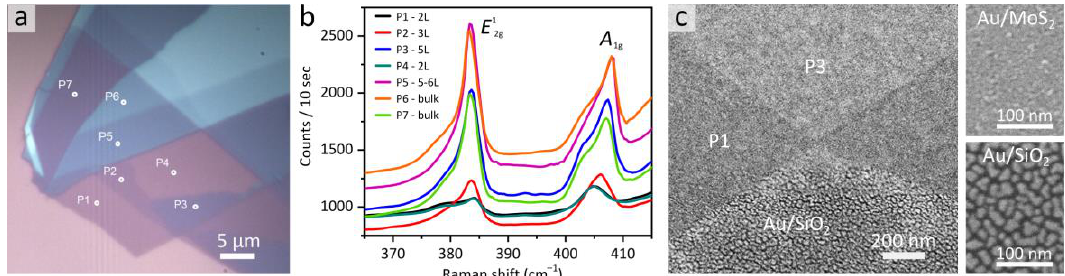
Figure 1. Optical microscopy ( a ) and Raman characterization ( b ) of a typical transferred few-layer MoS 2 flake on the SiO 2 /Si substrate. Various colors in the optical image are attributed to different thicknesses of MoS 2 , i.e., 2 L, 3 L, and thicker MoS 2 layers. The Raman spectra with a 632.8 nm excitation laser were collected from a spot size of about 1 μm at each measurement point at n-layered MoS 2 . ( c ) SEM image of the area across the Au/SiO 2 -Au/MoS 2 flake surface boundary after deposition of a 4-nm-thick Au film, small SEM images represent the surface morphology of gold on MoS 2 and SiO 2 .